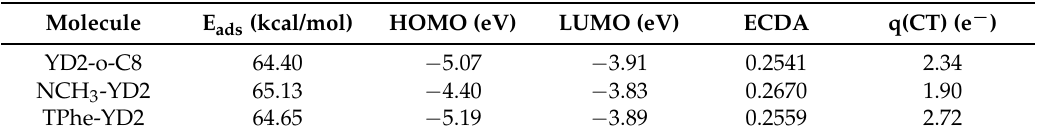
Figure 7. The optimized molecular structures (Å) and electron density distributions for the HOMO and LUMO orbitals of dyes/TiO 2 complexes. Table 5. The absorption energies (E ads ), HOMO and LUMO energies, ECDA, and q(CT) of the studied dyes.